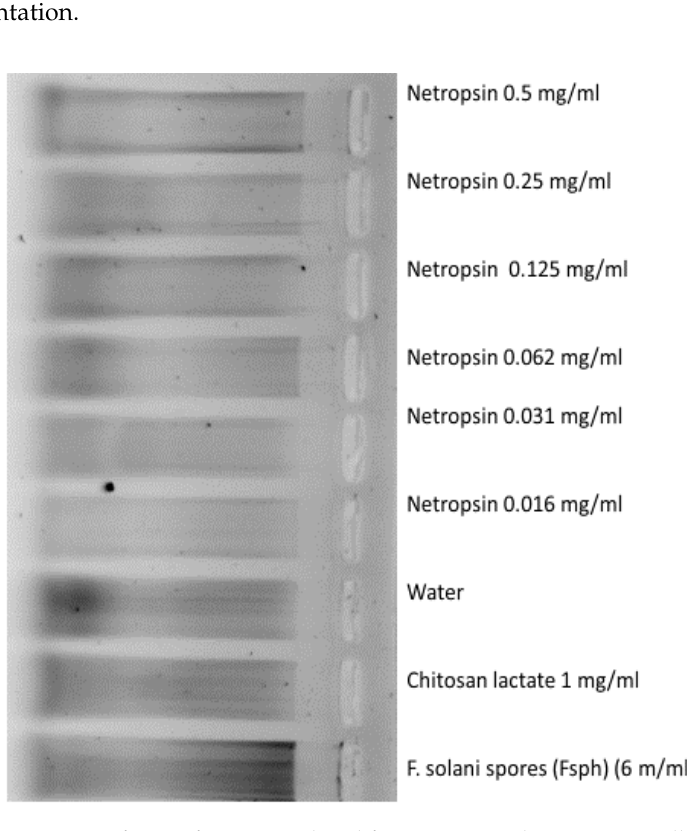
Figure 3. Gel separations of DNA fragments eluted from 15 µg total pea DNA in alkaline buffer and separated on agarose gel (See Methods) 2 h following the indicated treatments. Central ink dot marks the 1 kD size.